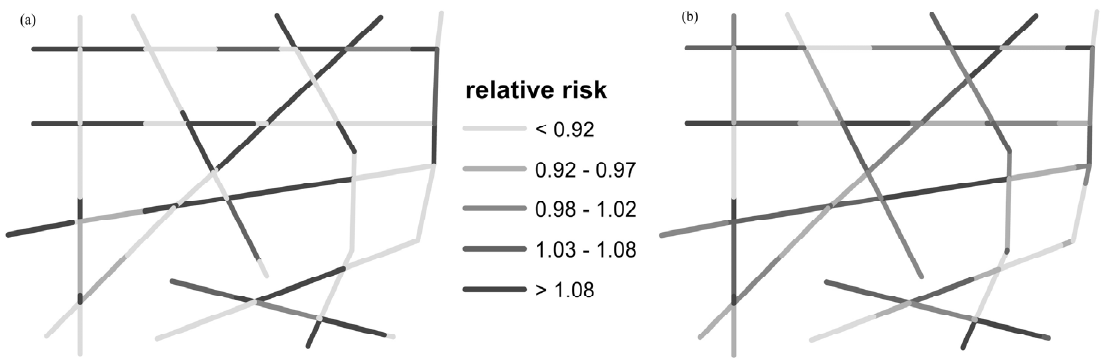
Figure 4. Distributions of relative risk: ( a ) crude risk; ( b ) smoothed risk. Table 1. The results of the proposed method under different scenarios.